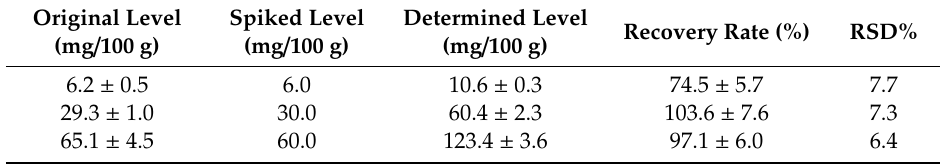
Table 1. Spiked recovery of the UHPLC-MS / MS method for determination of camel lactoferrin (n =